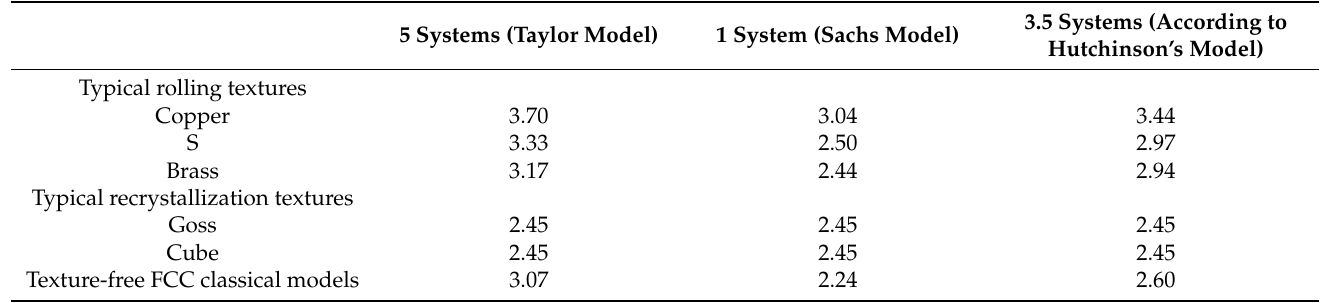
Table 2. M values for macroscopic loads in the rolling direction for different rolling and recrystalliza- tion textures [30].